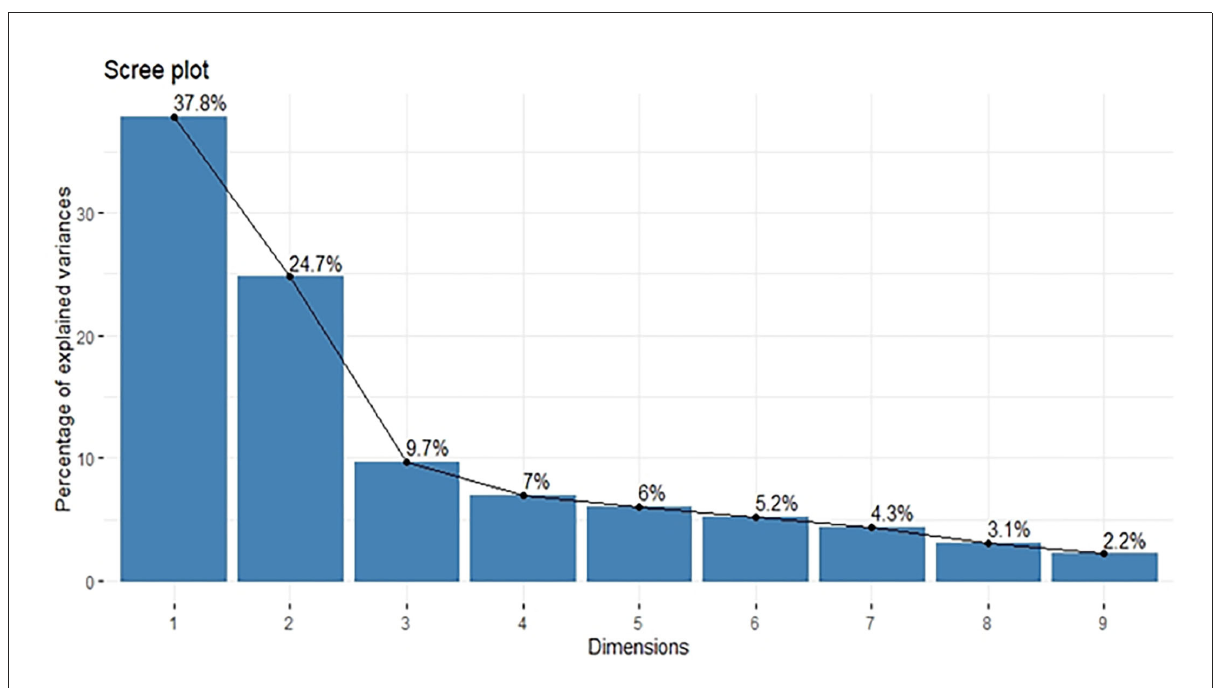
FIGURE2 Scree plot diagram of nine principal components with percentage of variance explained by each principal component.